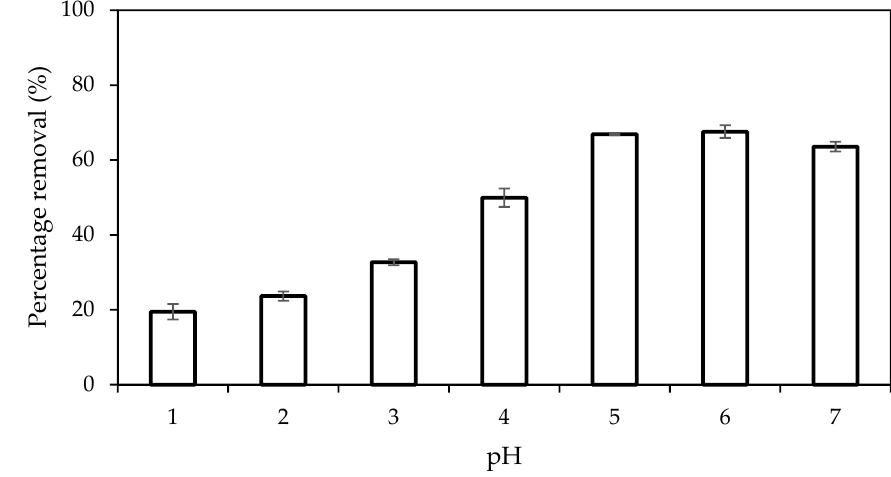
Figure 13. Effect of pH on the percentage removal of Pb(II) ions. Condition: dosage of adsorbent = 40 mg, contact time = 240 mins, [Pb(II)] = 125 mg/L.